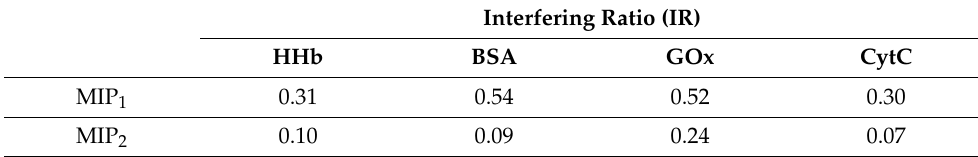
Table 1. Interfering ratio (IR) estimated for MIP 1 and MIP 2 at a concentration of 20 µ M (292